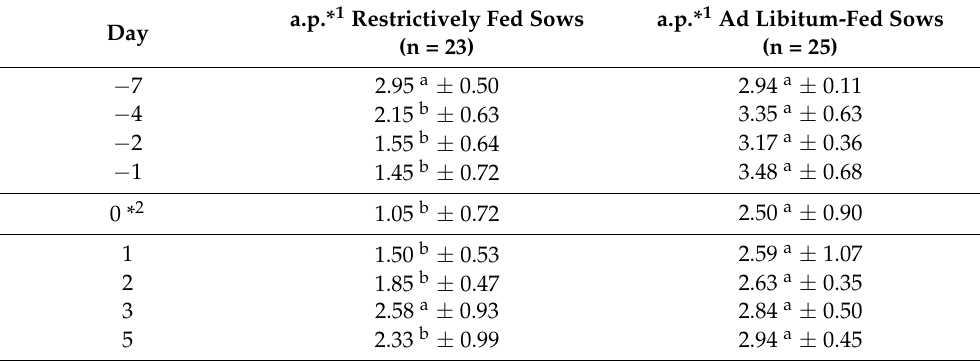
Table 8. Mean values of the faecal score of the ante partum (a.p.) restrictively fed sows and the a.p. ad libitum-fed